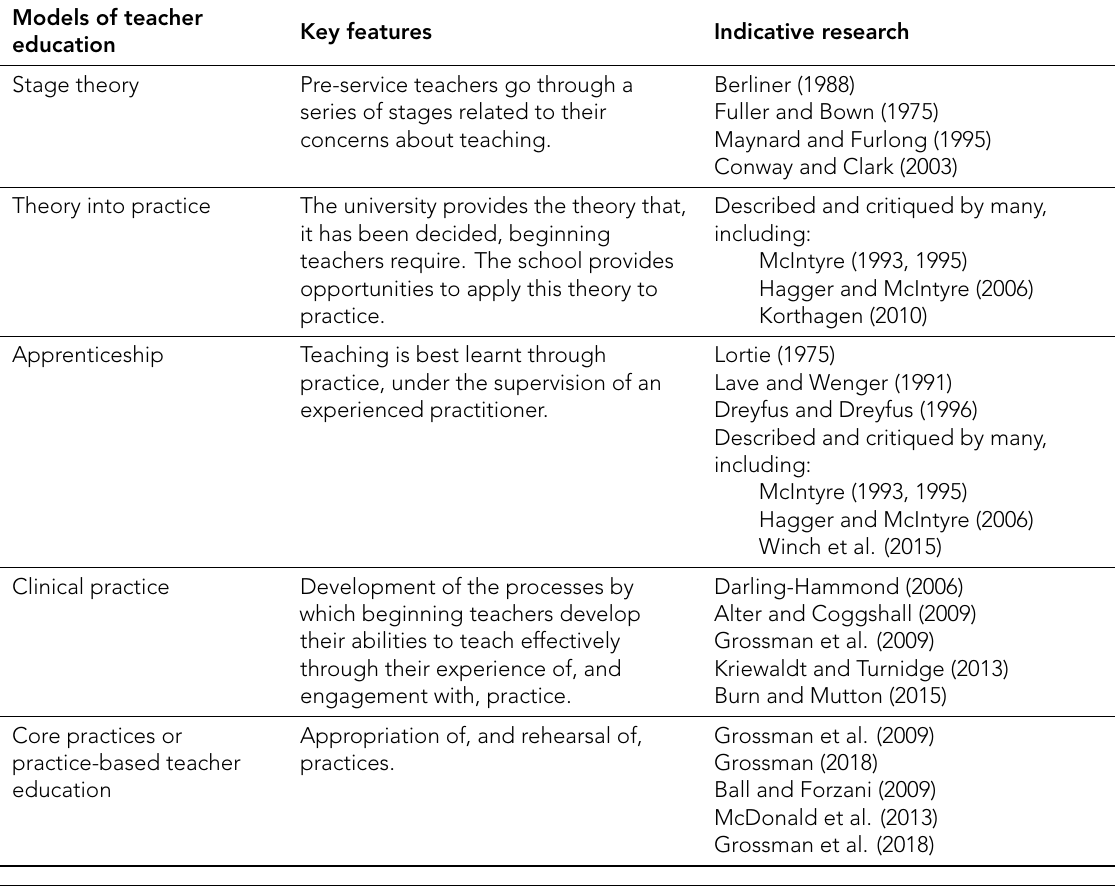
Table 1. Models of teacher education (Source: Authors,